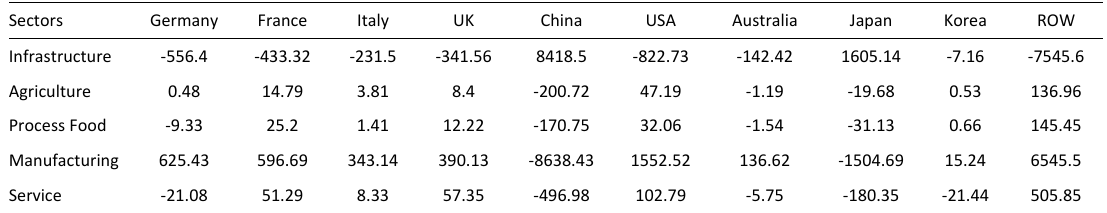
Table 3: Change in trade balances by sector (millions of dollars)